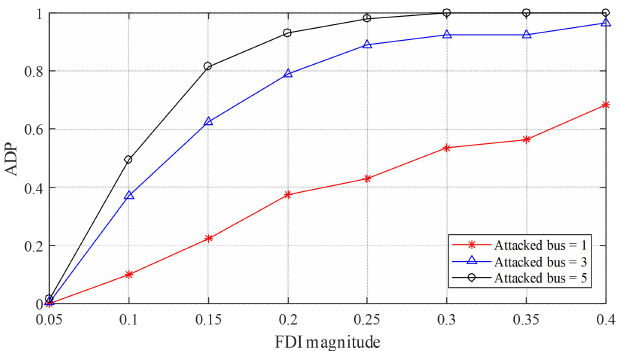
Figure 14. The ADP of RHMTD against the data-driven alert attacker. Table 3. ADP of existing HMTD methods and RHMTD against three alert